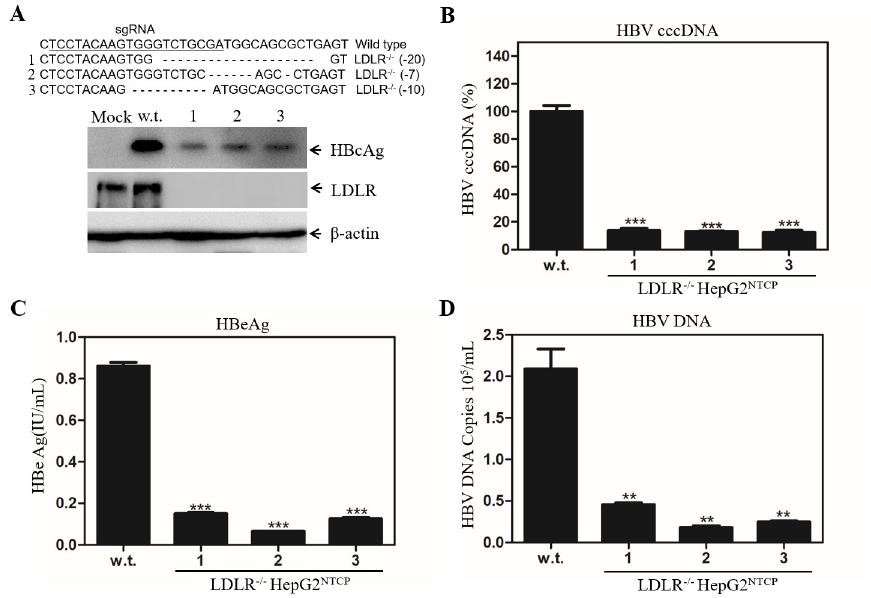
Fig 5. Impairment of HBV infection in the LDLR-knockout HepG2 NTCP cells. HepG2 NTCP cells were transduced with a lentivirus (LentiCRISPRv2-Blast/LDLR-sgRNA) expressing a Cas9 and LDLR-specific sgRNA. Upon selection with blasticidin (5 μ g/mL), stable cell clones were picked up and expanded. Genomic DNAs were extracted from stable cell lines and were used for amplification of the LDLR gene spanning the sgRNA-target region by PCR. PCR products were subjected to DNA sequence analysis. The nucleotide deletions of the LDLR gene from three stable cell lines are shown on the top of A. The deficiency of LDLR expression in the LDLR -/- cell lines was validated by Western blot analysis. The LDLR-deficient cell lines were infected with HBV in a parallel comparison with the parental HepG2 NTCP cells (w.t.). At 4-days p.i., the levels of LDLR and HBcAg were determined by Western blot using β -actin as a loading control ( A ). The levels of HBV cccDNA in the parental and LDLR-deficient cells were quantified by a Real-Time PCR method. The relative levels of cccDNA were converted to percentage (%) of that in parental cells which was considered 100% ( B ). The levels of HBeAg in the supernatants were quantified by a chemiluminescence immunoassay ( C ). The levels of HBV genomic DNA in the supernatants were quantified by Real-Time PCR and shown as genomic DNA copy numbers ( D ). Data were presented as average values ± standard deviation obtained from three independent experiments. �� P < 0.01, ��� P < 0.001.